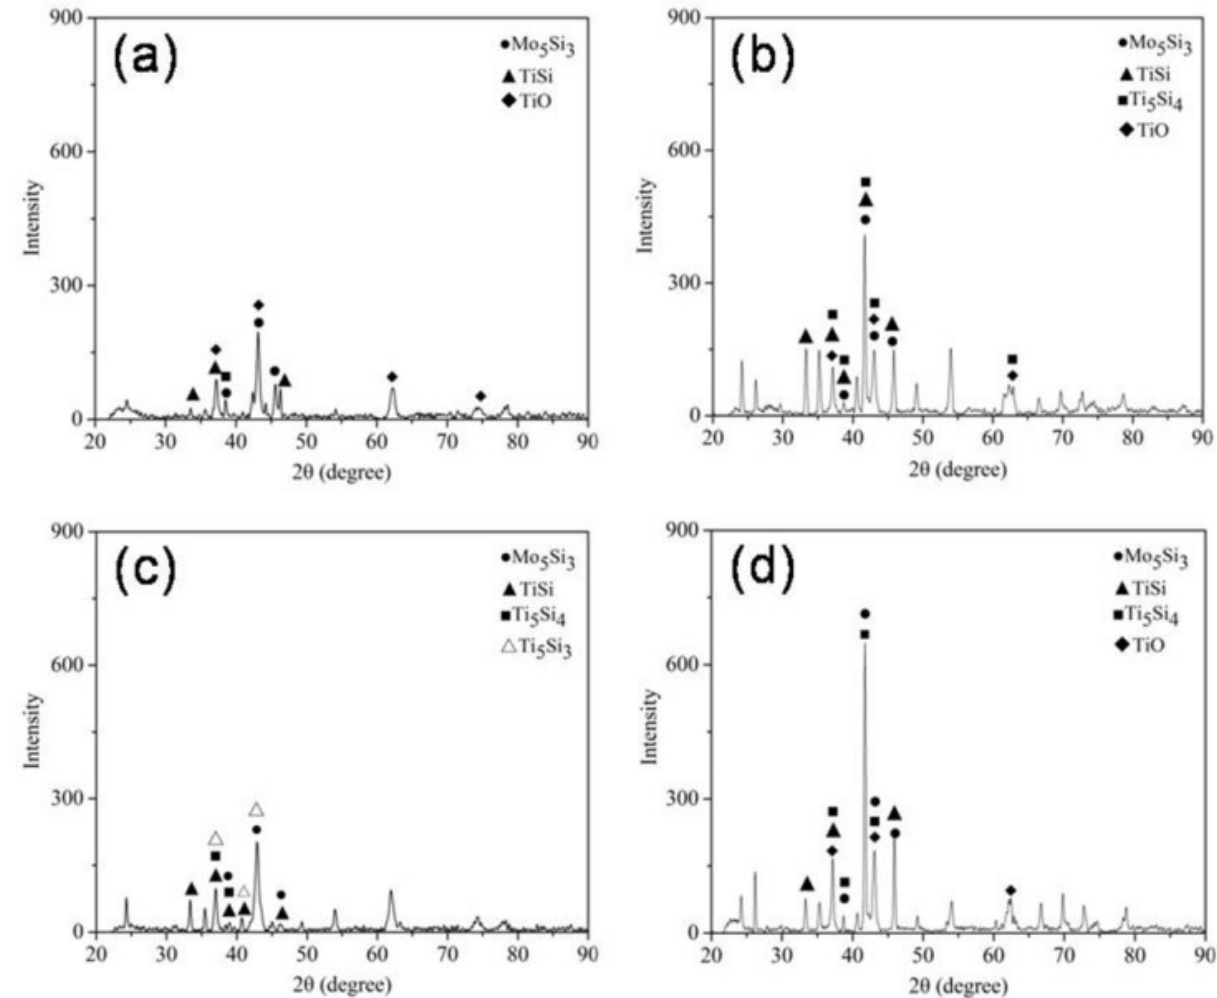
Figure 3: XRD patterns of sintered samples with different Mo contents: (a) 12 wt.%, (b) 14 wt.%, (c) 16 wt.%, (d) 18